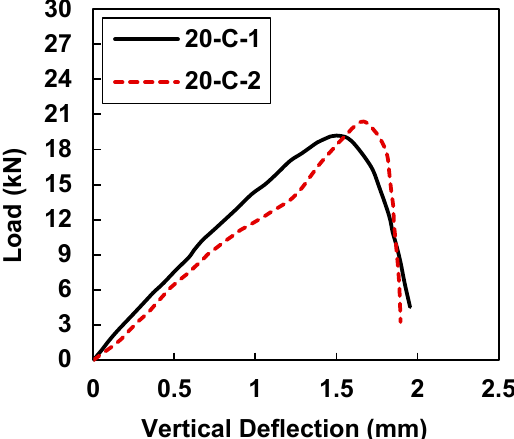
Figure 6. Load vs. midspan deflection for samples 10-C-1 and 10-C-2. Figure 7 exhibits an average increase of 25% in the load-carrying capacity and a 35% increase in the vertical deflection for the specimens strengthened with the CFRP strips with widths equal to 20 mm.